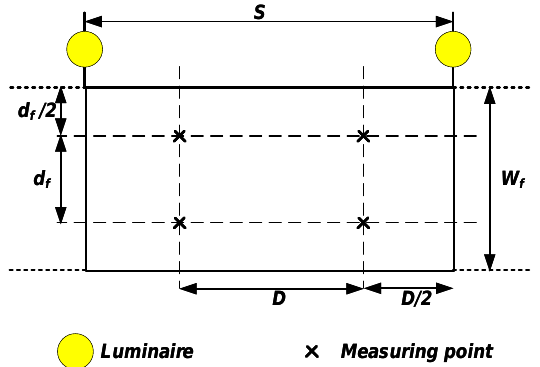
Figure 12. Reticulated mesh for illuminance